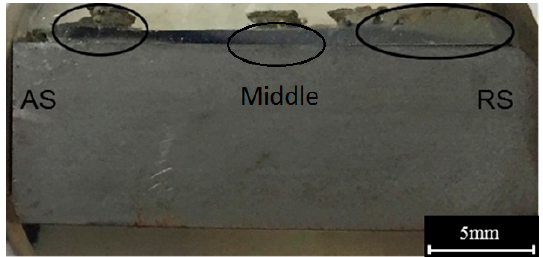
Figure 10. Metallographic specimen.